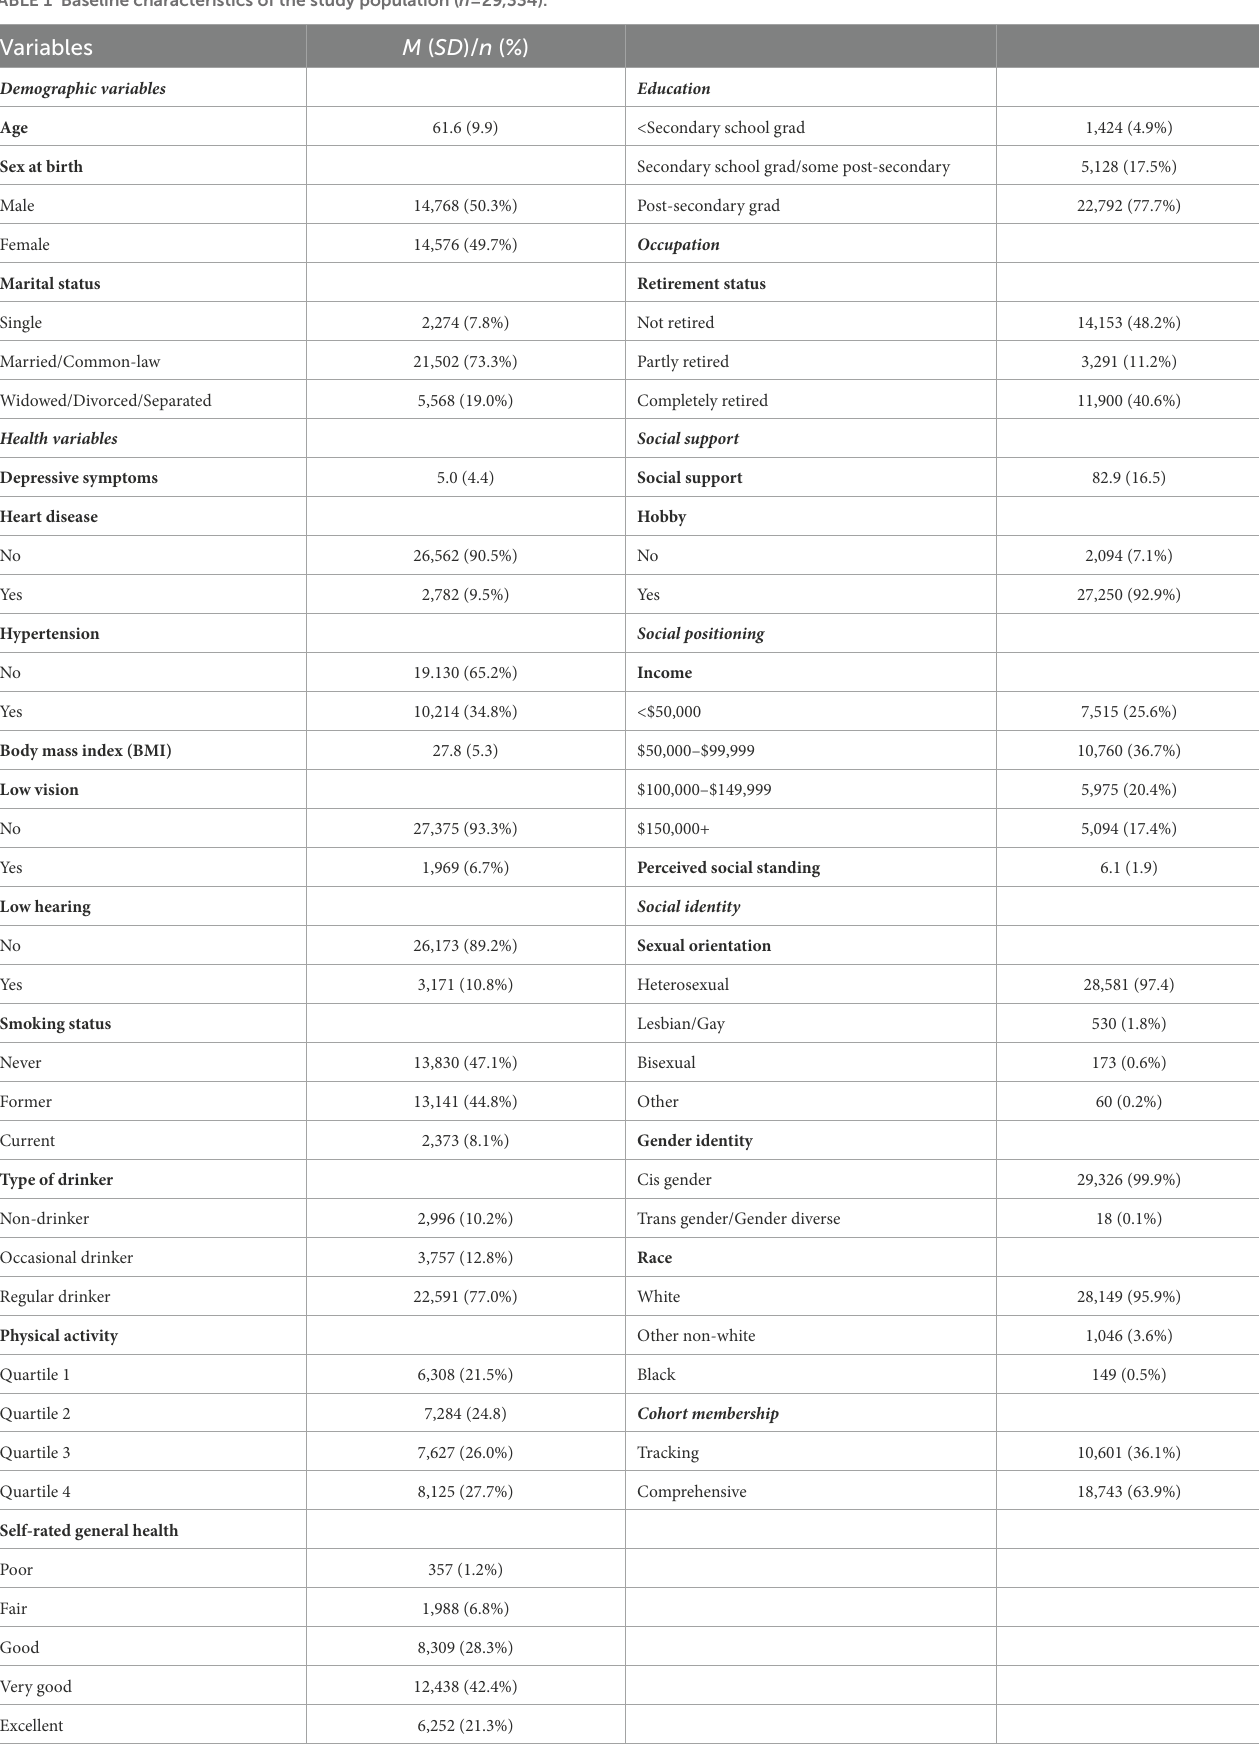
TABLE 1 Baseline characteristics of the study population ( n = 29,334).